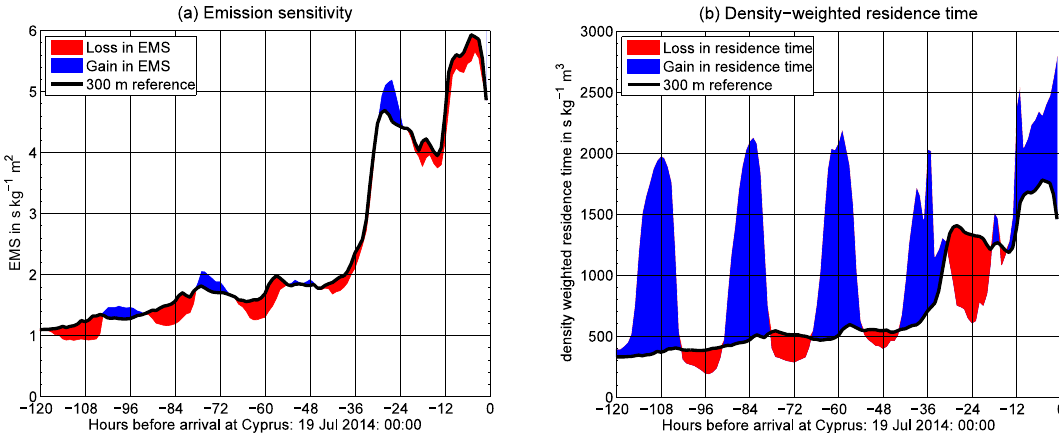
Figure 3. (a) Time series of spatially integrated emission sensitivity (EMS) based on variable boundary layer heights with positive differences (blue areas) and negative (red areas) in reference to the 300m assumption (black line). (b) Spatially integrated density-weighted residence time of boundary layer heights with differences shown by filled areas with respect to the 300m